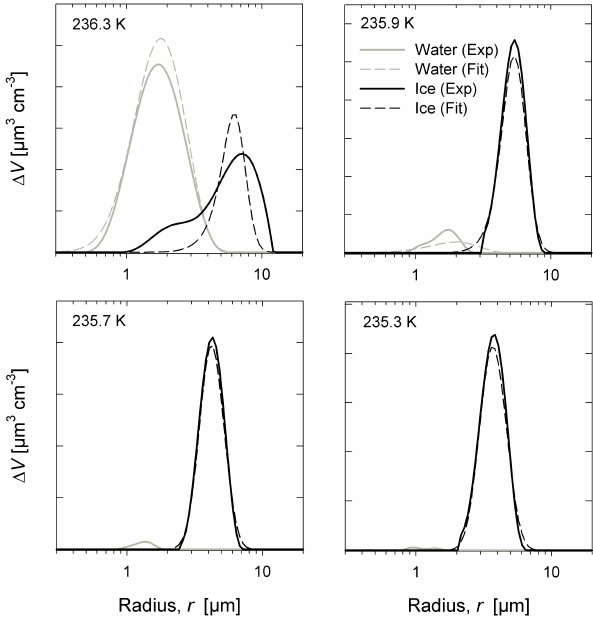
Fig. 9. Model fits to experimentally-measured distributions from partially frozen samples (medium droplets). The corresponding candidate freezing temperatures are indicated for the individual ex- periments.